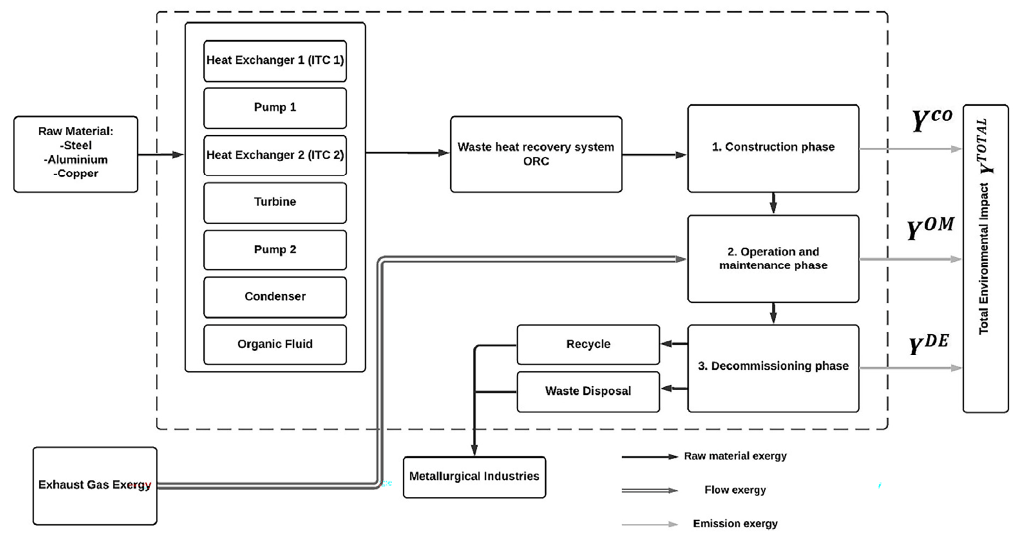
Figure 4. Life cycle assessment workflow.